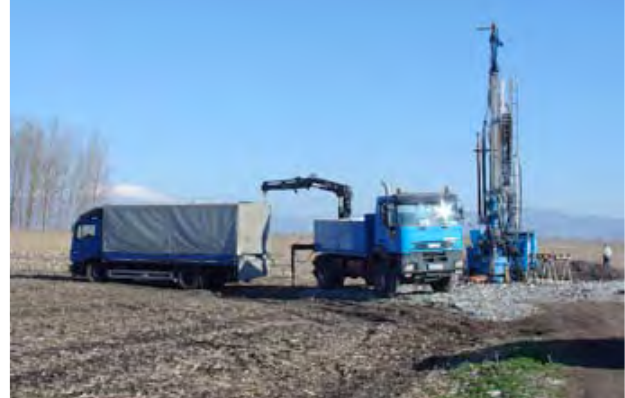
Figure 2. Drilling rig WIRTH Eco1 used for drilling in the Drama Basin. The Phalakron mountain range (2232 m a.s.l.), which borders the Drama Basin to the northeast, is visible in the background.